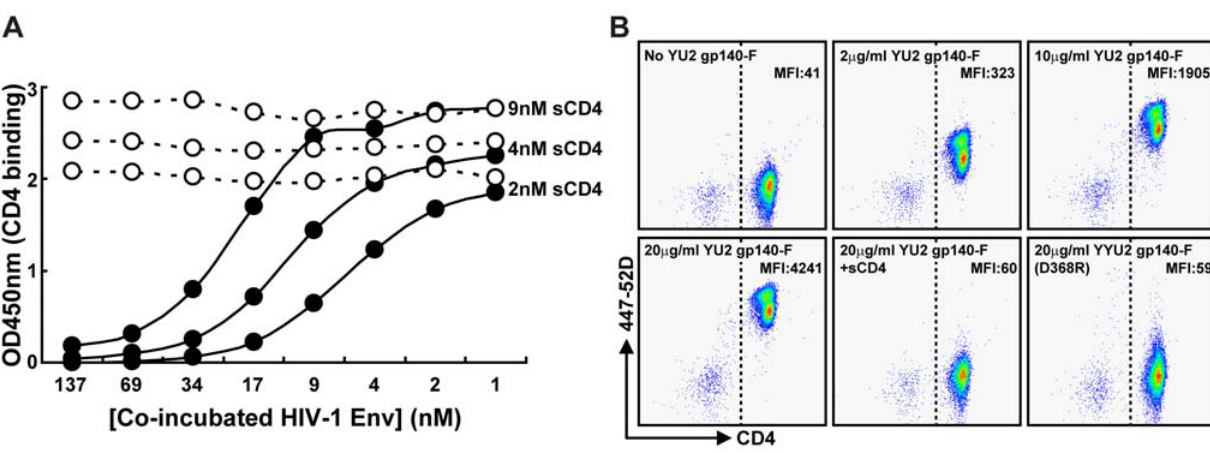
Figure 1. Soluble Env trimers bind to soluble and cell-surface CD4. (A) sCD4 at concentrations of 2, 4 and 9 nM was co-incubated with YU2 gp140-F trimers (filled circles) or CD4-binding-defective gp140 368D/R trimers (open circles) at concentrations shown. Subsequently, non-trimer- bound sCD4 was captured in an ELISA format by the anti-CD4 antibody RPA-T4, competing with HIV-1 Env for CD4 binding. RPA-T4-captured sCD4 was detected with the non-competing anti-CD4 antibody, OKT-4 and plotted as shown. (B) Cynomolgus macaque PBMCs were incubated with 2, 10 or 20 m g/ml of YU2 gp140-F trimers, 20 m g/ml gp140-F trimers in the presence of an excess sCD4 (100 m g/ml) or with 20 m g/ml of gp140-F 368D/R trimers. Cells were stained for CD3, CD4 and CD8 expression and analyzed by flow cytometry. The CD3 + /CD8 2 populations are shown (see supplemental FigS2 for gating strategy). The y-axis indicates Env binding, as detected with mAb 447-52D, and the x-axis shows CD4 expression. The CD4 + cell population was defined as cells detected to the right of the dotted line. The median fluorescence intensity (MFI) of Env binding to the CD3 + /CD4 + /CD8 2 cell population is shown.